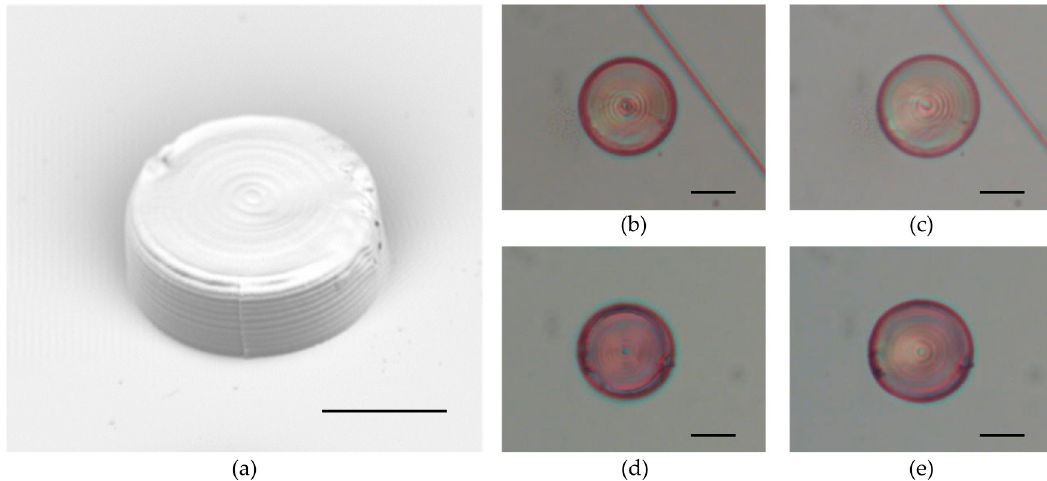
Figure 6. Light induced deformation. ( a ) SEM image of a cylinder made by PR-40 ; ( b , d ) optical image of a cylinder made respectively by PR-20 and PR-40 before irradiation; ( c , e ) optical image of a cylinder made respectively by PR-20 and PR-40 during irradiation with green light. Scale bar: 15 µm.